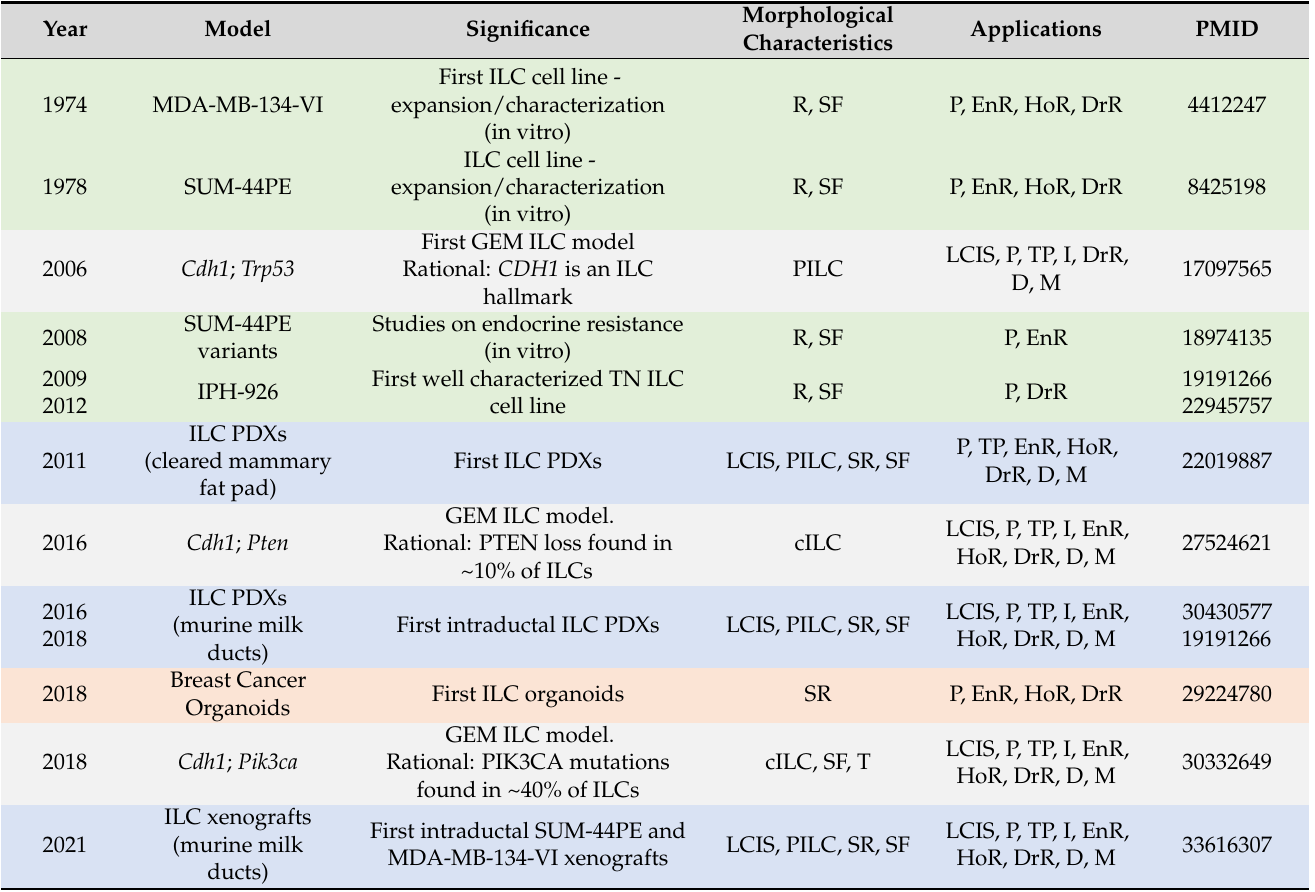
Table 1. Milestones timeline of key lobular models development and their applications. Chronological list of the key ILC models leading to existing lobular models and their established and future applications. Abbreviations: P, proliferation; TN, triple negative; GEM model, genetically engineered mouse model; LCIS, lobular carcinoma in situ; I, invasion; TP, tumor progression; EnR, endocrine response, and resistance; HoR, hormone responsiveness; C, chemoresistance; D, dormancy; M, metastasis; MM134, MDA-MB-134-VI; SUM44, SUM-44PE; PMID, PubMed identifier; PILC, pleomorphic ILC; SR, signet ring morphology; T, targetoid; R, round; SF, single-cell-file pattern. Color code: green, cell lines in vitro; grey, GEMMs; orange, organoids; purple, xenografts, and